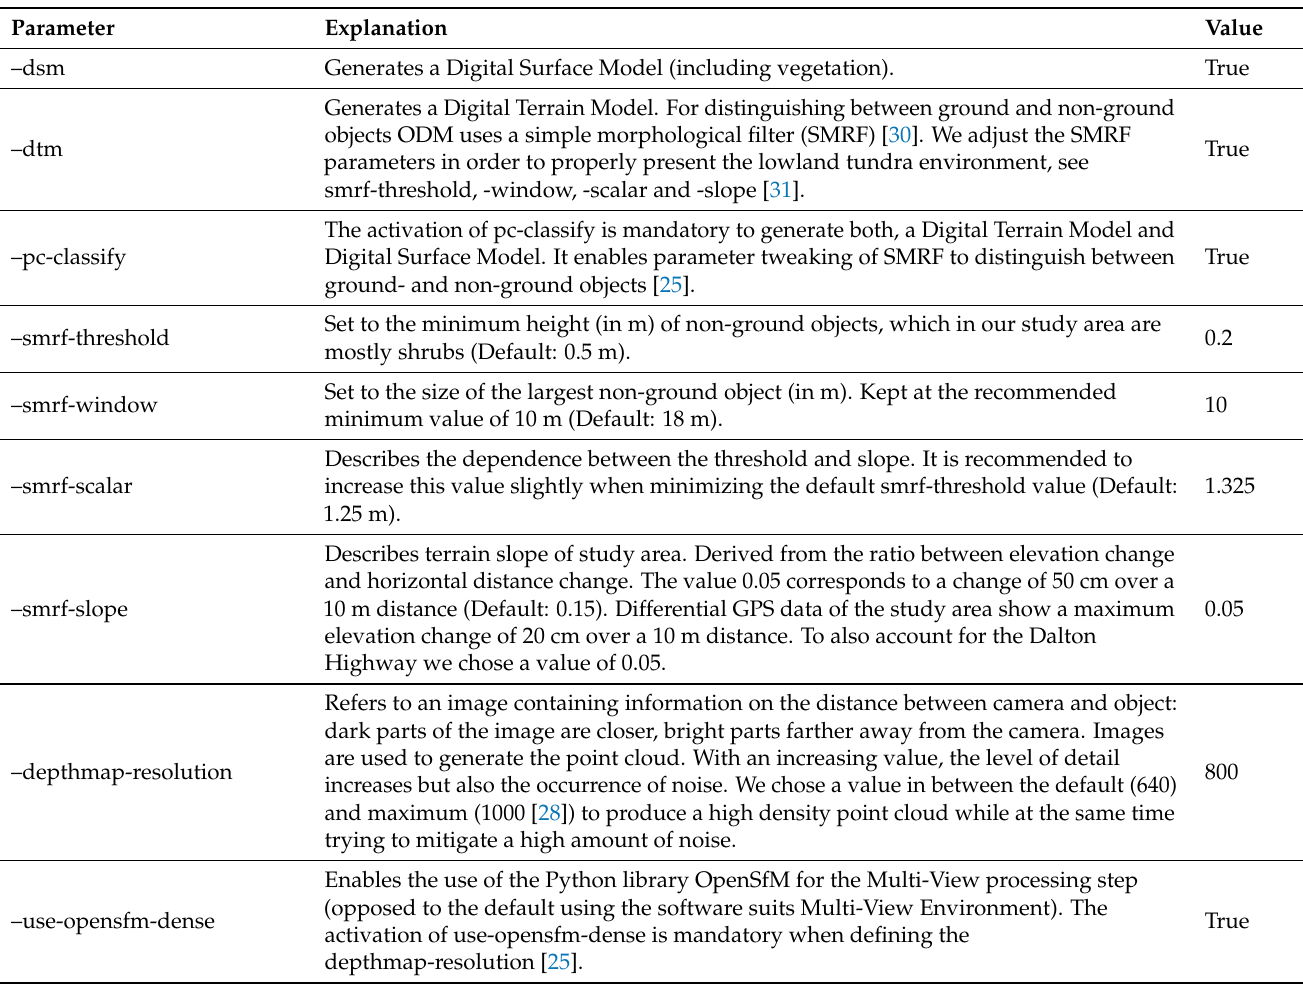
Table 2. Modified WebODM Lightning default settings used for the study area photogrammetry prod- ucts development derived from field measurements, observations and the official OpenDroneMap software guide [25]. Copyright © 2019 by Piero